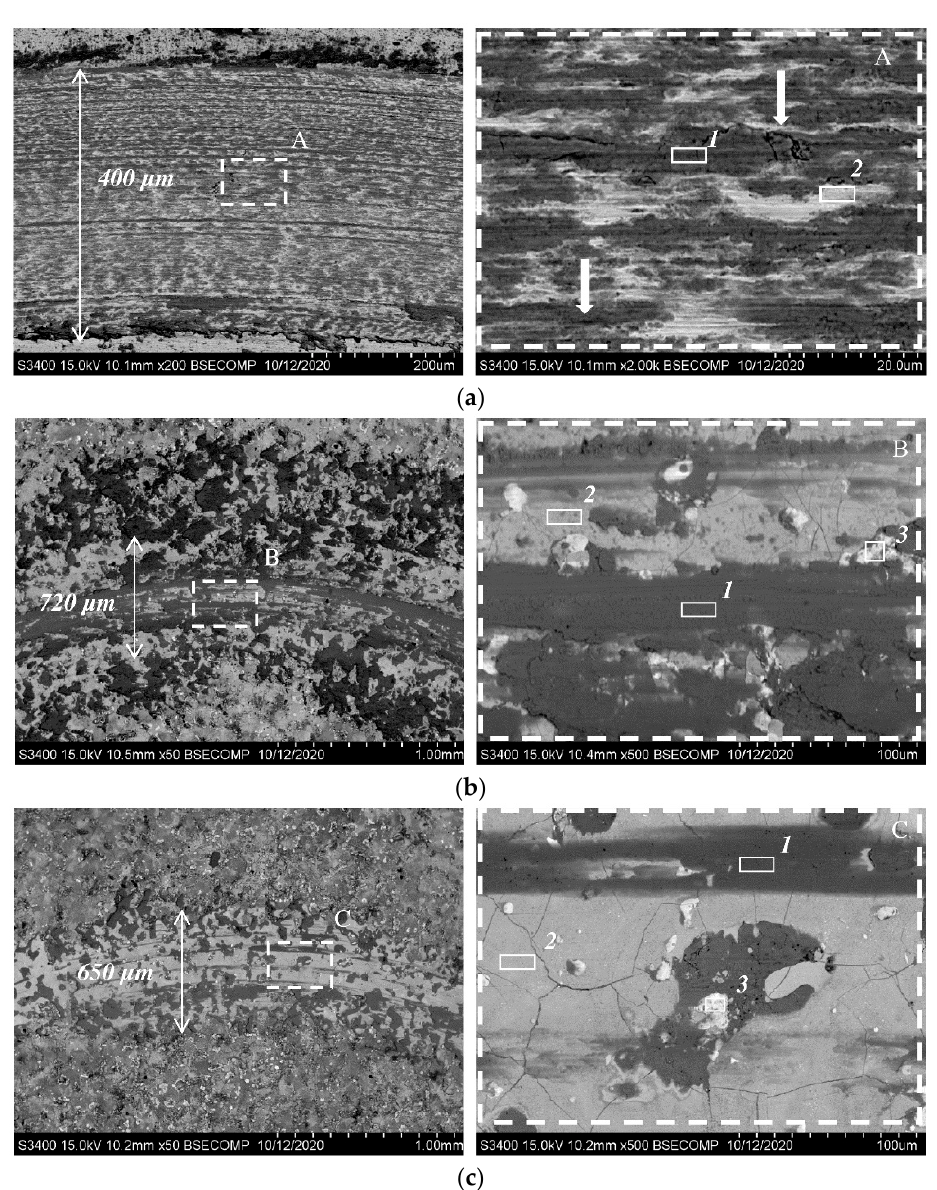
Figure 9. SEM images of the wear tracks after tribological tests at 700 °C for ( a ) uncoated substrate; ( b ) as-deposited; and ( c ) vacuum-annealed coating. Table 4. EDS data for different areas of the wear tracks (Figure